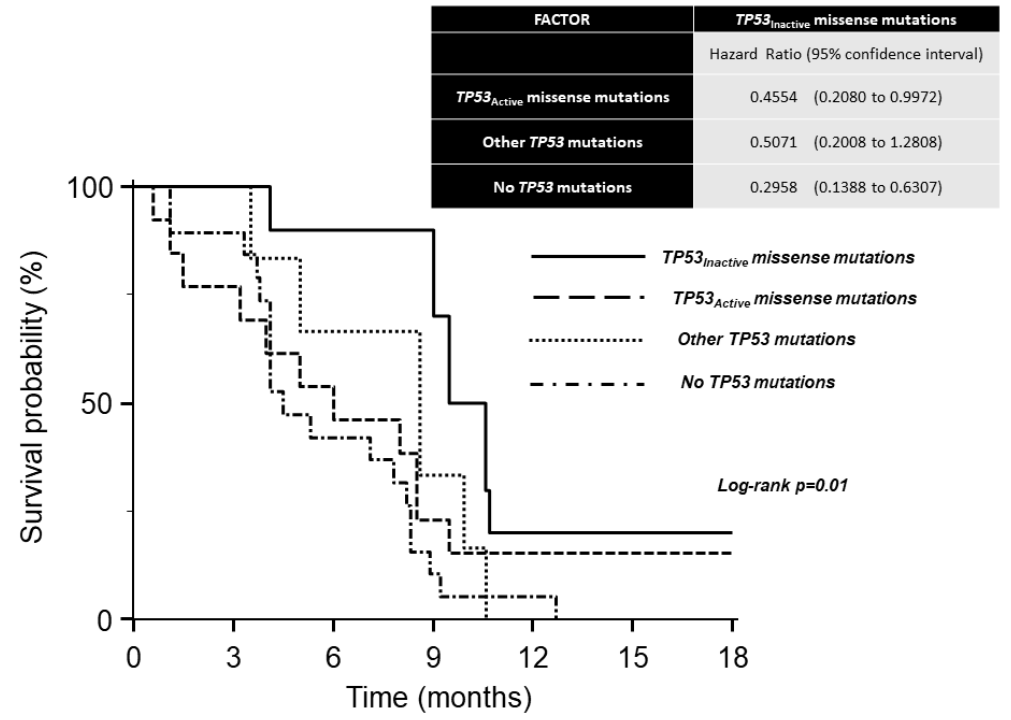
Figure 1. Kaplan–Meier survival curves of Ramucirumab / Paclitaxel second-line therapy in 48 patients with metastatic gastric cancer.